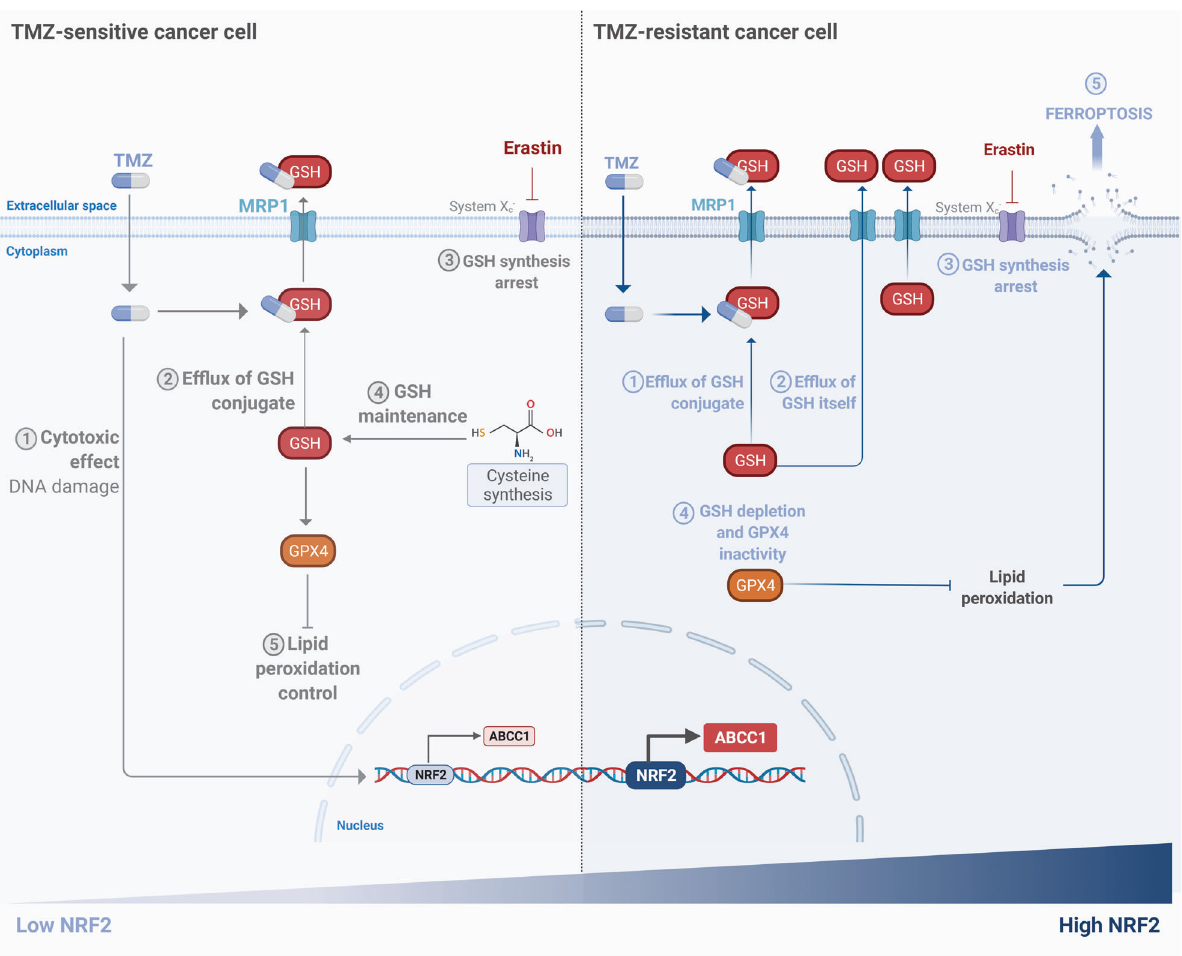
Fig. 7 Schematic view of the mechanism of ferroptosis sensitivity in drug-resistant glioma cells. TMZ-resistant cells have higher expression of NRF2 and, consequently, higher levels of ABCC1 /MRP1. Upon treatment with TMZ, GSH mediates drug ef fl ux by GSH-conjugate through MRP1 channels enhancing chemotherapy tolerance. Simultaneously, higher levels of MRP1 promote GSH ef fl ux. Upon treatment with Erastin, there was a decrease in GSH synthesis, which is accentuated by GSH ef fl ux through MRP1 promoting GPX4 inactivity and sensitizing these cells to ferroptosis. In contrast, TMZ-sensitive cells can obtain cysteine through compensatory mechanisms to generate GSH synthesis, thus they become resistant to ferroptosis. Created with